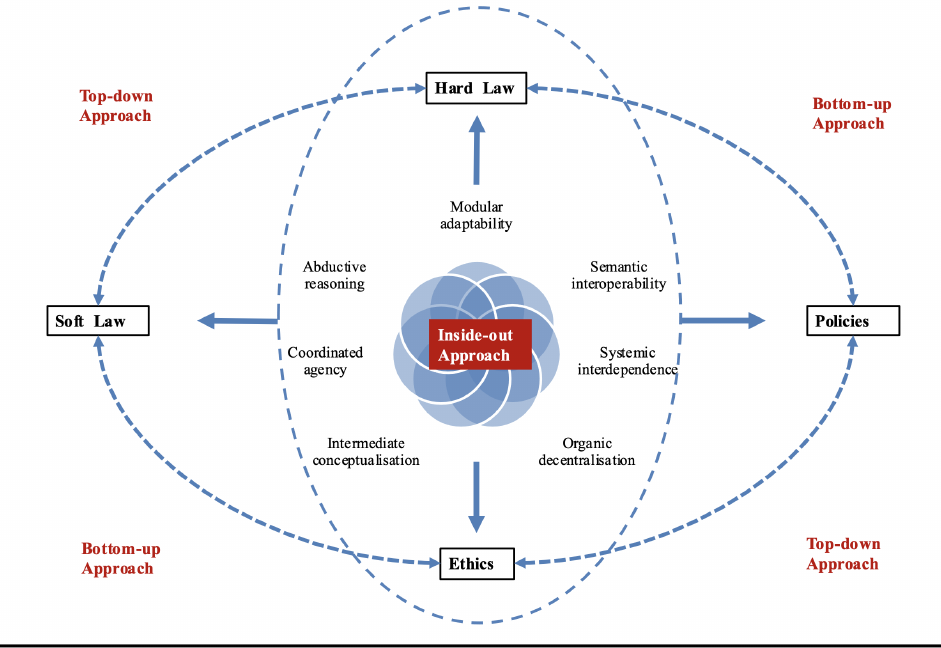
Figure 3. Inside-out Approach to LoD, WoD, and IoT regulatory